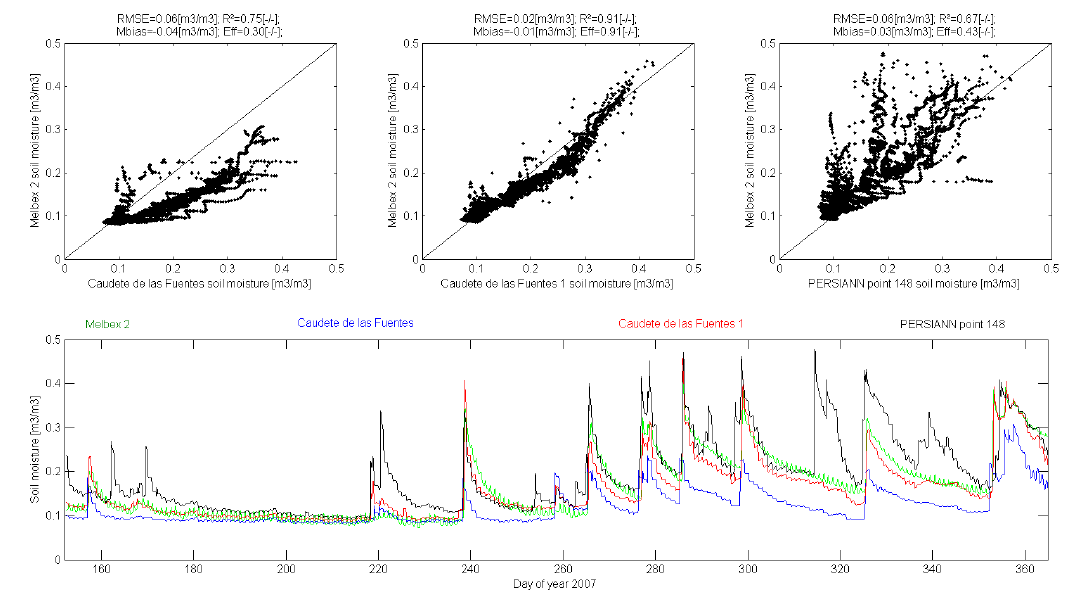
Fig. 6. Simulated soil moisture integrated over top 5cm of soil using Caudete de las Fuentes rain gauge, Caudete de las Fuentes 1 rain gauge and the PERSIANN point 148 compared to Melbex 2 in situ soil moisture from 1 June to 31 December 2007.